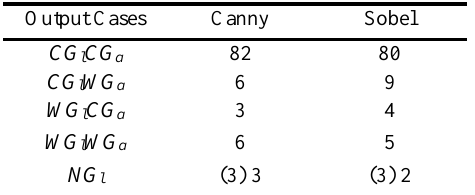
Table3. Similar output cases of glint and gaze detection (%).